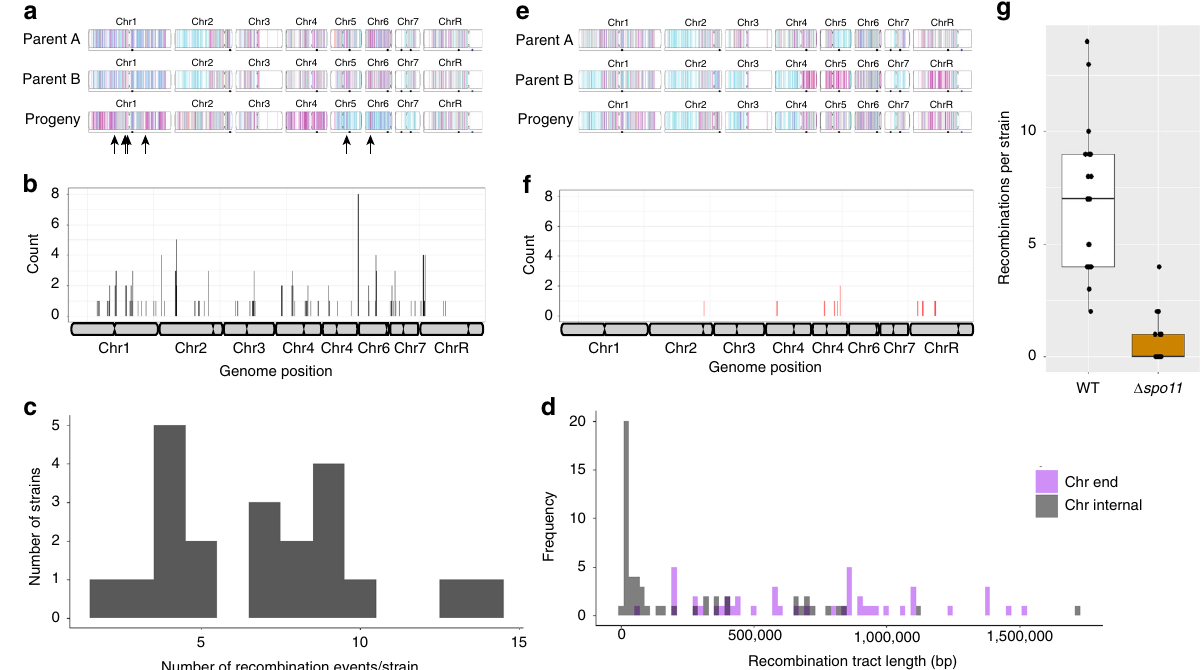
Fig. 3 Genomic analysis of C. albicans CCL progeny. Parental and progeny genotypes are shown for three representative strains in WT a and Δ spo11 e backgrounds. The parental genotypes are indicated on the top two lines with a representative progeny underneath. Arrows indicate recombination breakpoints. Homozygous alleles for homolog A or B are represented by cyan and magenta lines, respectively, with heterozygous positions denoted as gray. The recombination breakpoints were mapped to the genome across all 21 genotyped WT b and Δ spo11 f progeny. c The number of recombination events within each WT progeny following CCL. d The length of each recombination tract in WT progeny was determined for chromosome internal tracts (gray) and tracts extending to the chromosome end (purple). n = 46 biologically independent data points. g The number of recombination breakpoints was compared for WT (white) and Δ spo11 (orange) progeny. Boxplots are presented as the 25th to 75th percentile with the thick line denoting the median. Whiskers indicate the largest and smallest values within 1.5 × of the interquartile range. n = 20 biologically independent